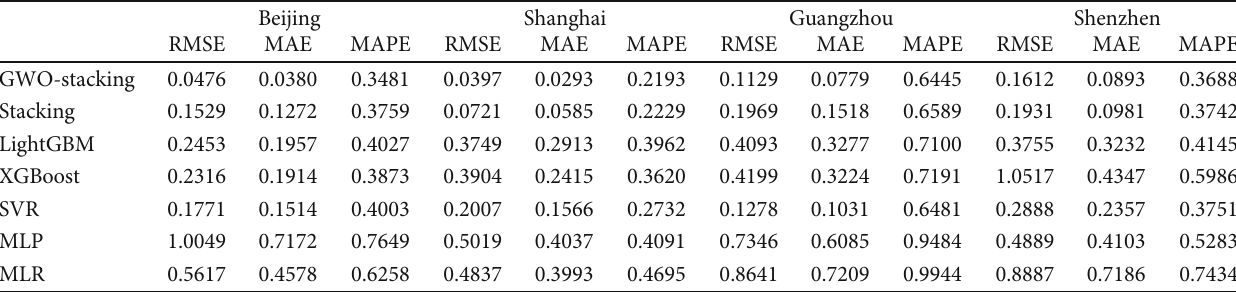
Table 4: Comparison of the prediction accuracy of di ff erent models in four